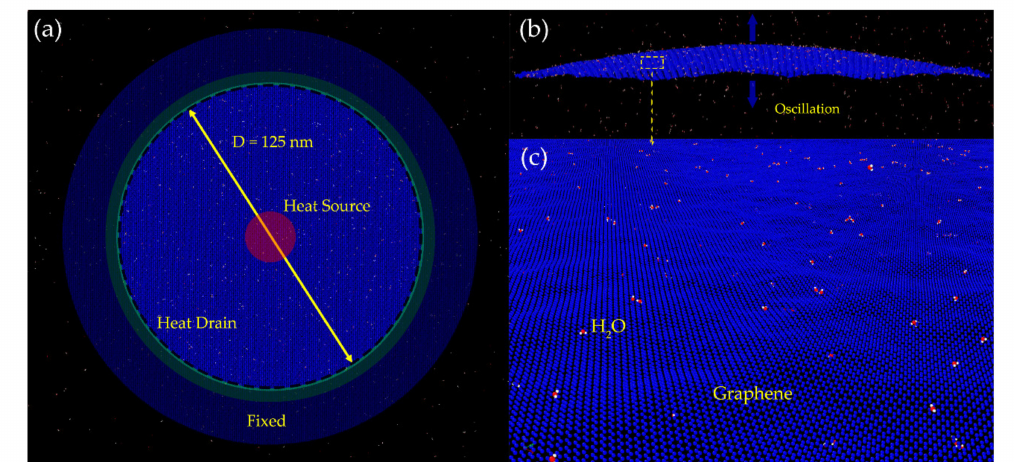
Figure 3. ( a ) MD model of the peripherally clamped circular graphene resonator for mass sensing. ( b ) An overview of the mechanical fundamental eigenmode of the peripherally clamped circular graphene. ( c ) The features of the graphene surface with water molecules serving as adsorbed